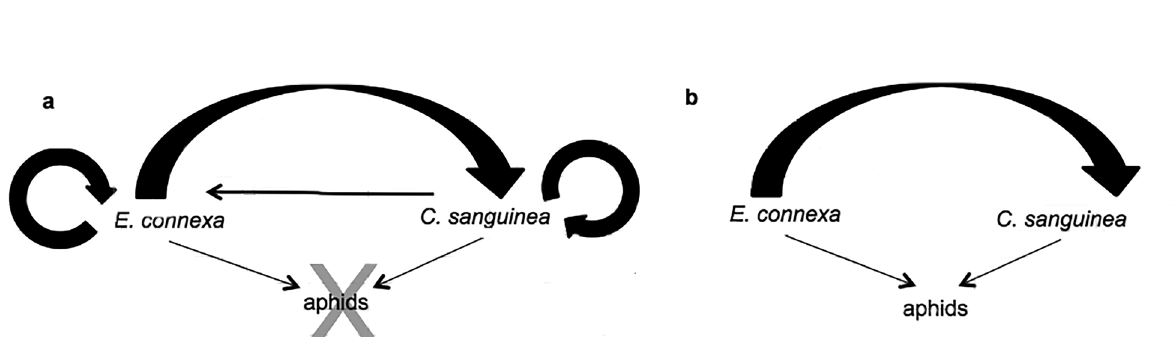
Figure 4. Semi-quantitative schematic illustration of the relative intensities of cannibalism and intraguild predation in conspecific (circular arrows) and heterospecific (adjoining arrows) interactions, respectively, between larval instars of Cycloneda sanguinea and Eriopis connexa , in ( a ) the absence or ( b ) the presence of prey ( Myzus persicae aphids). The thicker the arrows, the higher the relative intensity of the